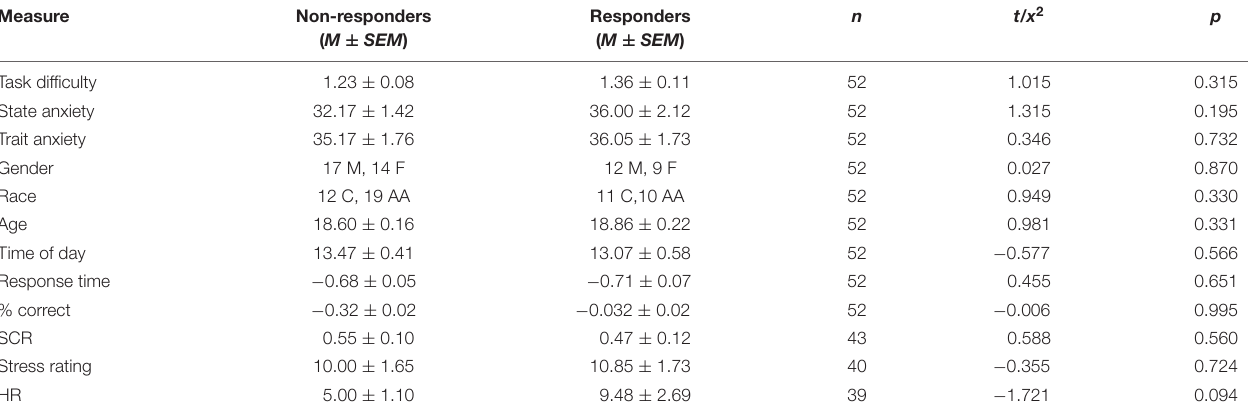
TABLE 3 | Cortisol Responders ( n = 21) compared to Non-responders ( n = 31). Measure